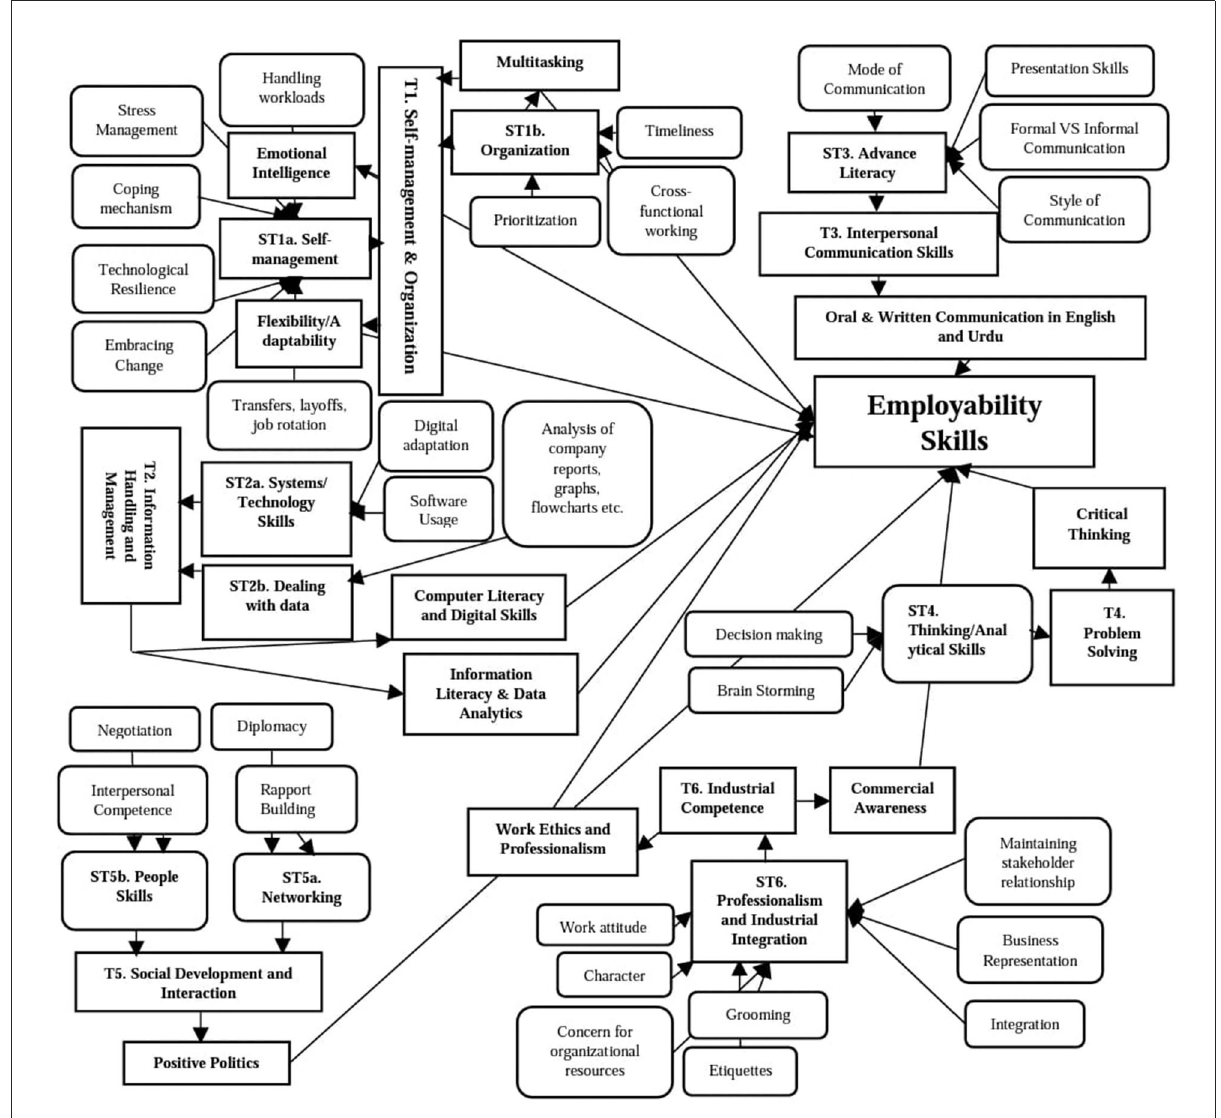
FIGURE2 Thematic map illustrating the key codes under each sub-theme which are then compiled under distinct themes, thus each theme then directs to its associated employability